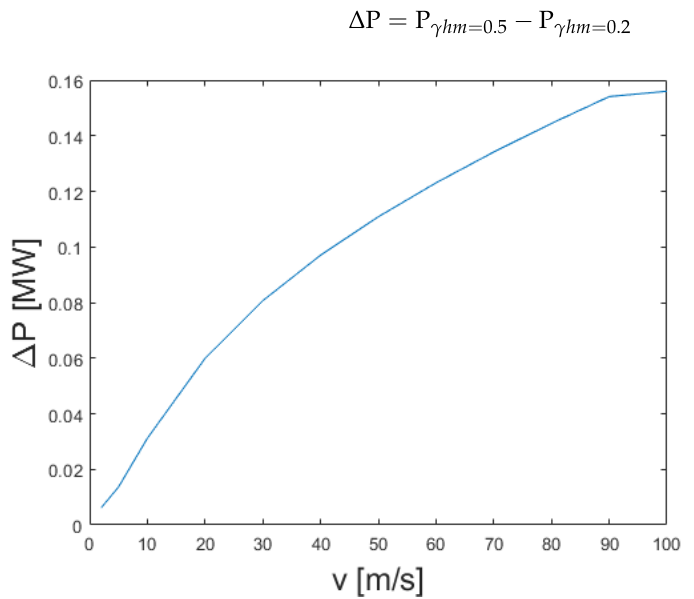
Figure 10. The difference of required power for fill factor = 0.5 and fill factor = 0.2 as a function of velocity. of